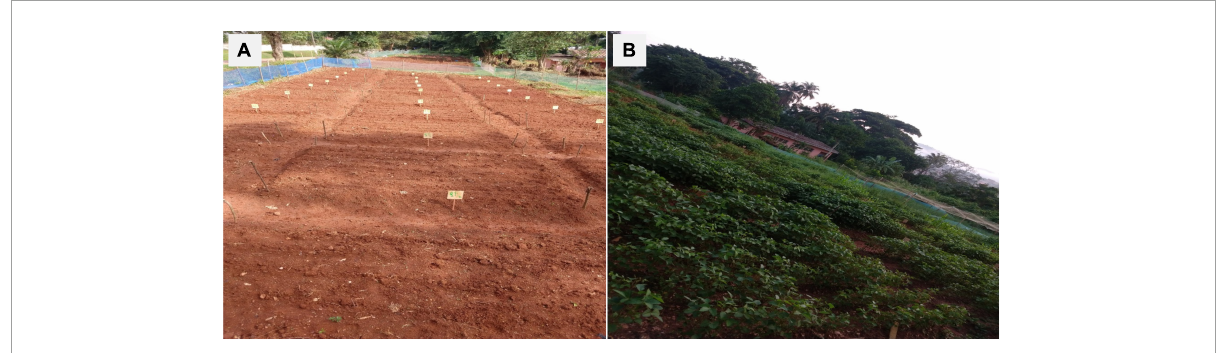
FIGURE1 Experimental site with tilled soil beds before sowing (A) and soybean plants at full podding (B) .